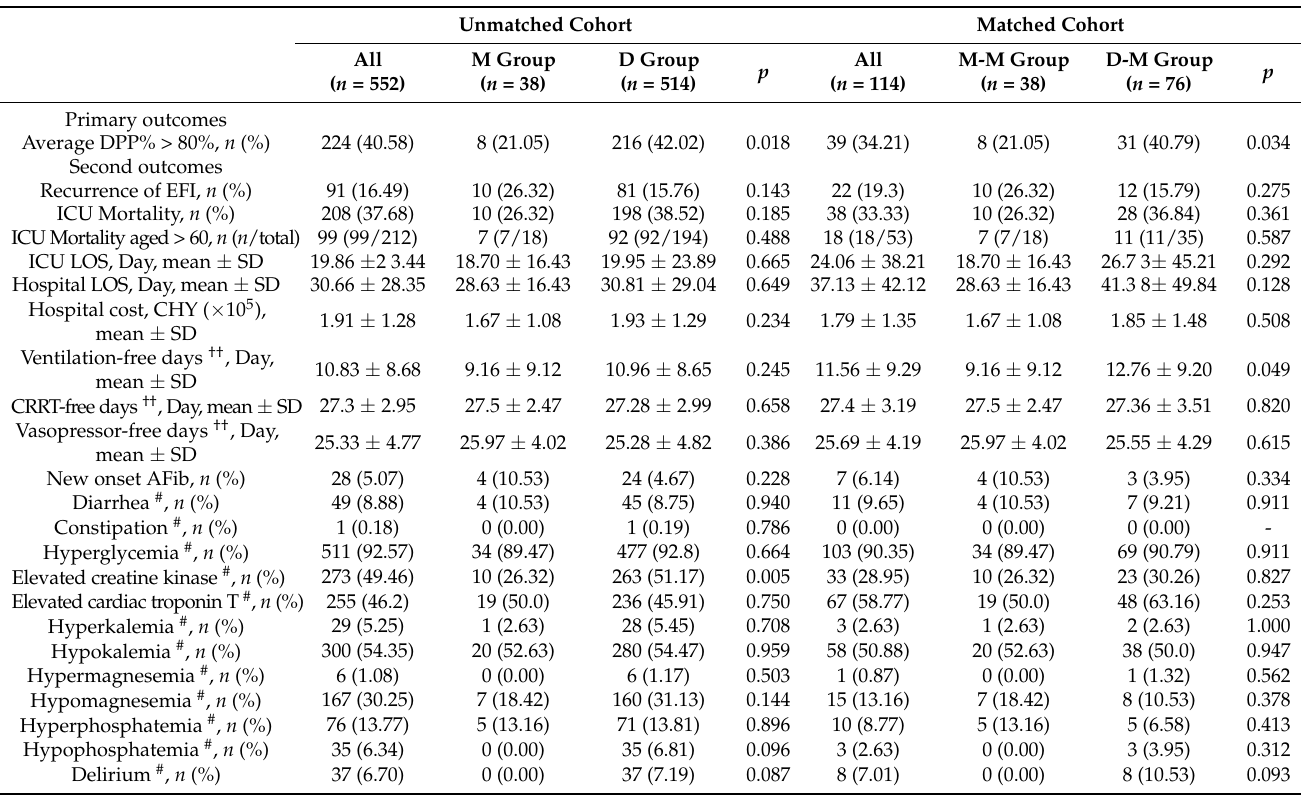
Table 2. Main results for primary and secondary outcomes.